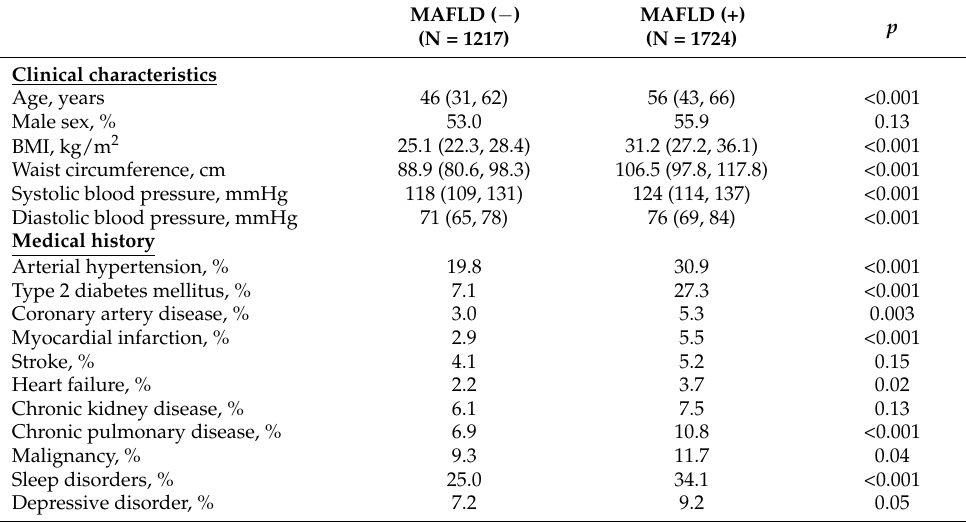
Table 1. Sociodemographic characteristics and medical history of the study population according to the presence of metabolic dysfunction-associated fatty liver disease (MAFLD).